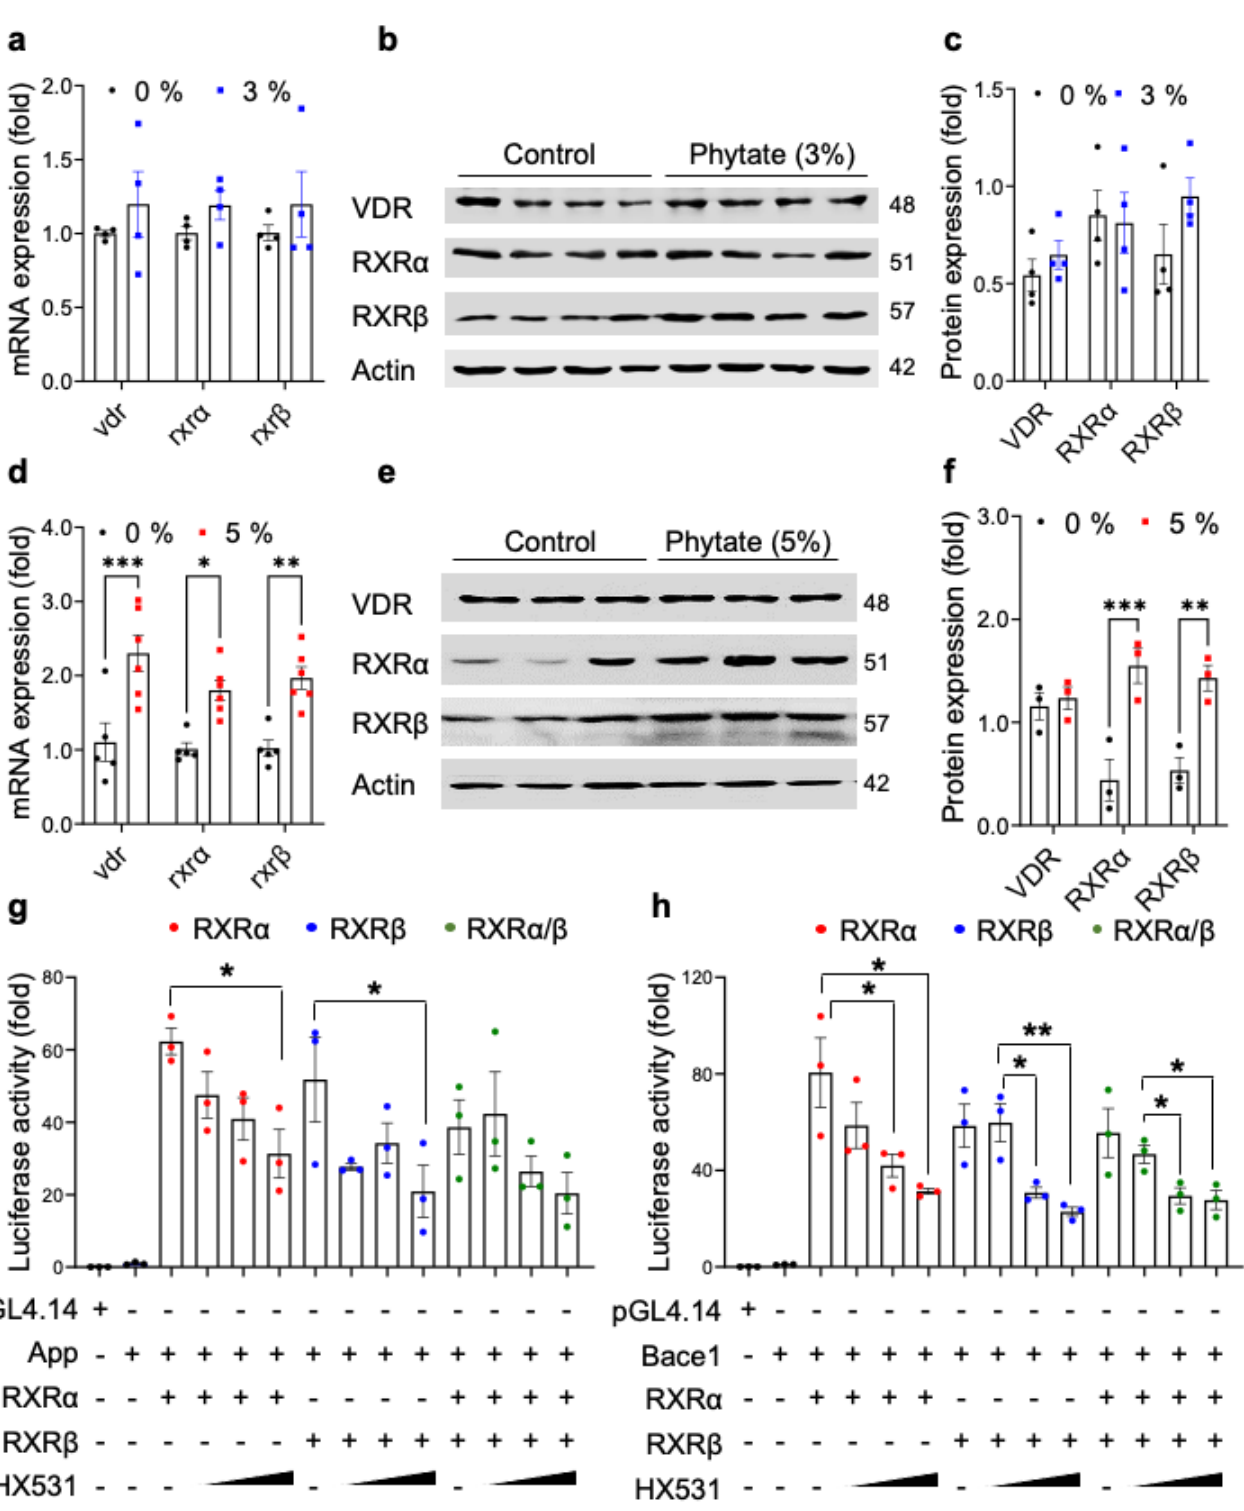
Figure 4. The RXR antagonist HX531 suppresses the transcriptional activity of rxr α / β and vdr in the app and bace1 promoters in vitro: ( a ) The mRNA expression of rxr α , rxr β , and vdr in the whole brain in rats fed 0% (control, n = 4) and 3% ( n = 4) phytate after 18 weeks of the diet. ( b ) Immunoblot analysis of RXR α , RXR β , and VDR from the whole-brain lysates from rats fed 0% (control, n = 4) and 3% ( n = 4) phytate after 18 weeks of the diet. The molecular weight is marked to the right of the bands. ( c ) The protein expression was quantified by calculation of the intensity of each band from the same blot and normalization to actin. ( d ) The mRNA expression of rxr α , rxr β , and vdr in the whole brain in rats fed 0% (control, n = 6) and 5% ( n = 6) phytate after 18 weeks of the diet. ( e ) Immunoblot analysis of RXR α , RXR β , and VDR from the whole brain